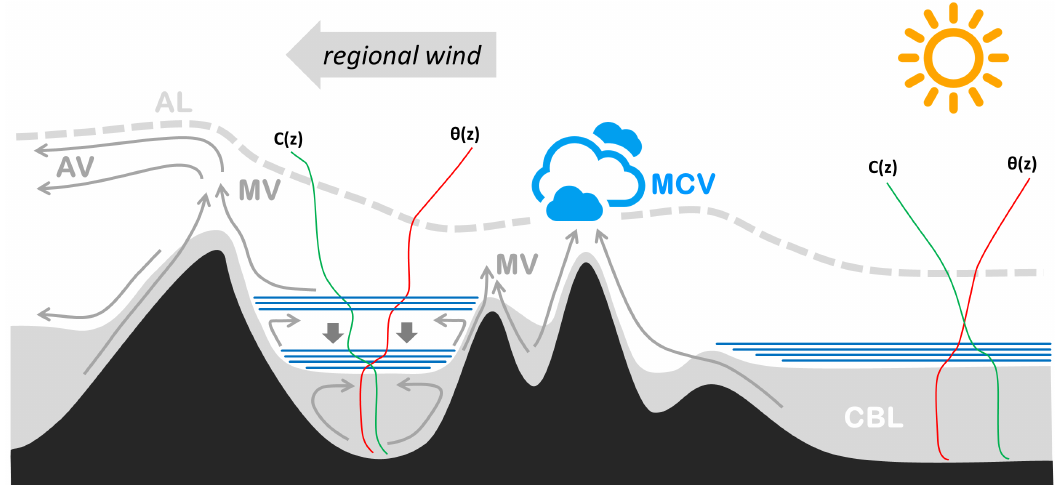
Figure 3. Exchange processes in the daytime boundary layer over mountainous terrain (adapted from [15,99,146–148]). Grey shading indicates the ground-based mixed layer (CBL). MV, AV, and MCV denote, respectively, mountain venting, advective venting, and mountain-cloud venting. Arrows indicate airflow, while C ( z ) and θ ( z ) indicate vertical profiles of pollutant concentration and potential temperature, respectively. Horizontal blue lines represent layers with enhanced static stability, which favour the separation of up-slope flows from the ground. Down-pointing arrows represent valley-core subsidence. The dashed line indicates the top of the regional aerosol layer